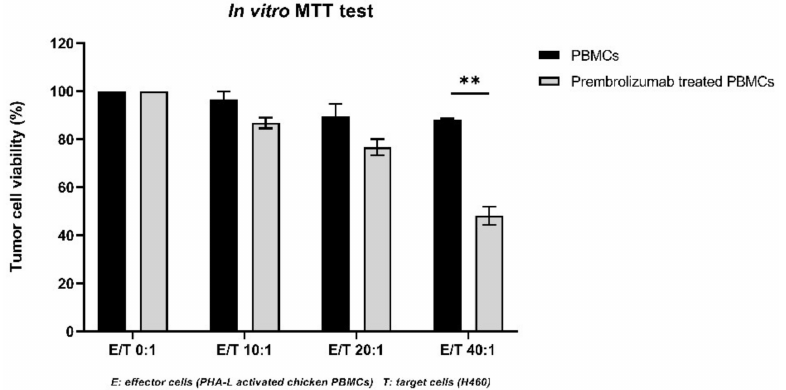
Figure 4. Restored effector cytotoxicity of PHA-L activated chicken PBMCs following pre-treatment with pembrolizumab was revealed through an MTT-based assay. Purified chicken PBMCs were activated in vitro by incubation in PHA-L at 5 µ g/mL for 72 h and then treated with pembrolizumab at 10 µ g/mL for 24 h Cytotoxicity of PHA-L stimulated PBMCs was then estimated using a co-culture with H460 cells as targets, at different E/T ratios (10:1, 20:1 and 40:1). PHA-L activated PBMCs without pembrolizumab pre-treatment were applied as the control. Tumor cell viability was measured through an MTT-based assay. The restored cytotoxicity of effector cells related to the pembrolizumab pre-treatment was significant when the E/T ratio was 40/1, p = 0.0089